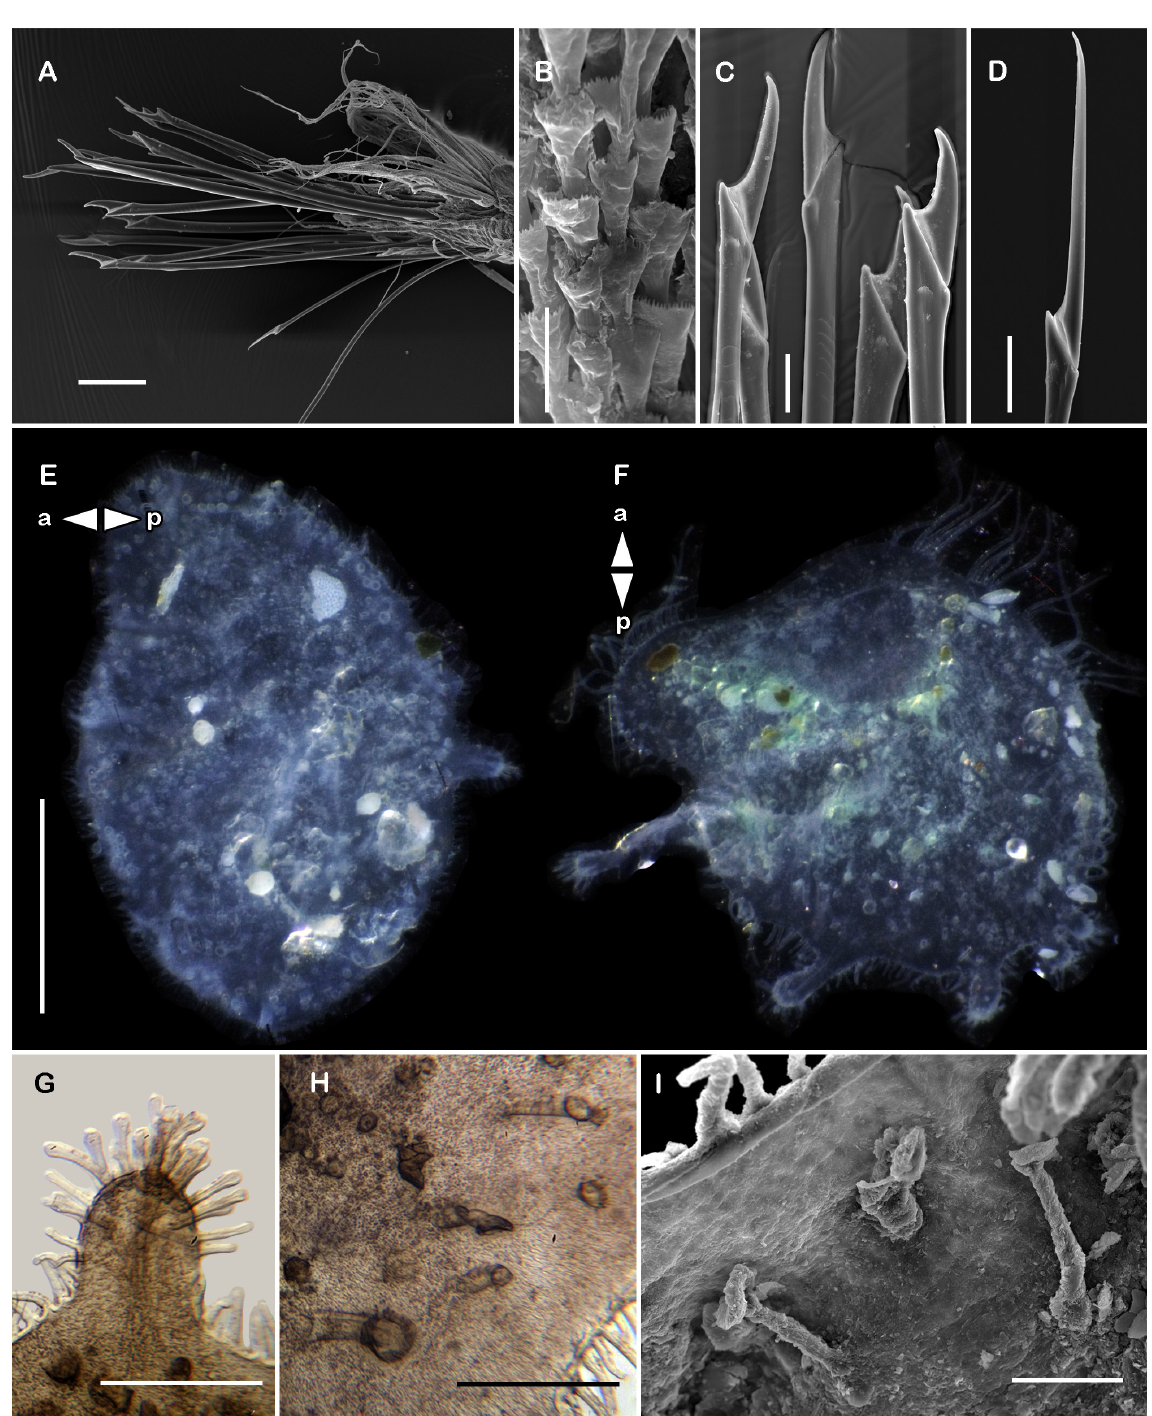
Fig. 18. Pelogenia kinbergi (Hansen, 1882), non-type specimen (UMML 6806-0694). A–D, I. SEM micrographs. A . Right parapodium from segment 25. B . Notochaetae from same. C . Units A and B. D . Unit D. E . First right elytron. F . Right posterior elytron. G . Posterior process from E. H . Margin from E. I . Surface of posterior elytron, marginal dendritic papillae and pedunculate papillae with flat tips. Abbreviations: a = anterior; p = posterior. Scale bars: A = 200 μm; B = 10 μm; C–D, I = 50 μm; E–F = 1 mm; G–H =